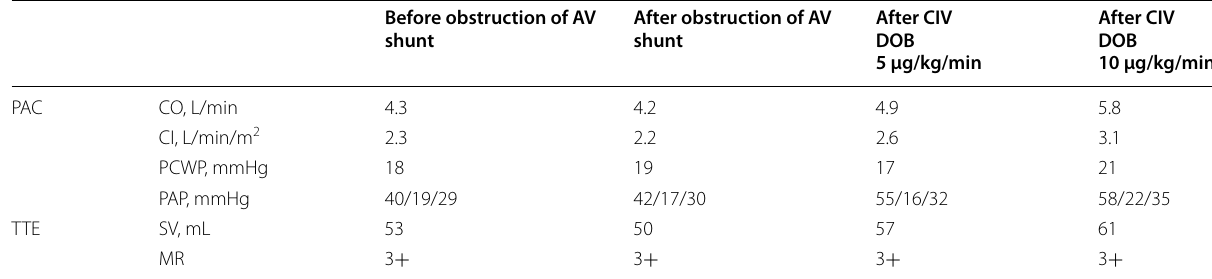
Table 1 Preoperative cardiac function Before obstruction of AV shunt AV arteriovenous, CI cardiac index, CIV continuous intravenous, CO cardiac output, DOB dobutamine administration, MR mitral regurgitation, PAC pulmonary artery catheter, PAP pulmonary artery pressure, PCWP pulmonary capillary wedge pressure, SV stroke volume, TTE transthoracic echography